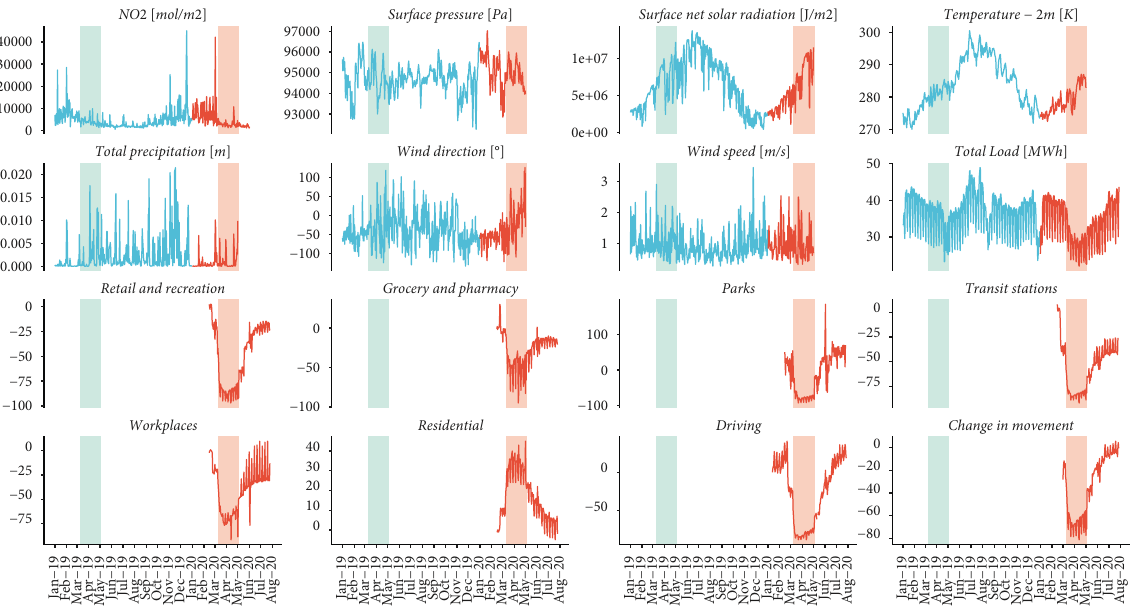
Figure 1: Observables used as a proxy for measuring variations in environmental conditions and human activities during the Italian lockdown.